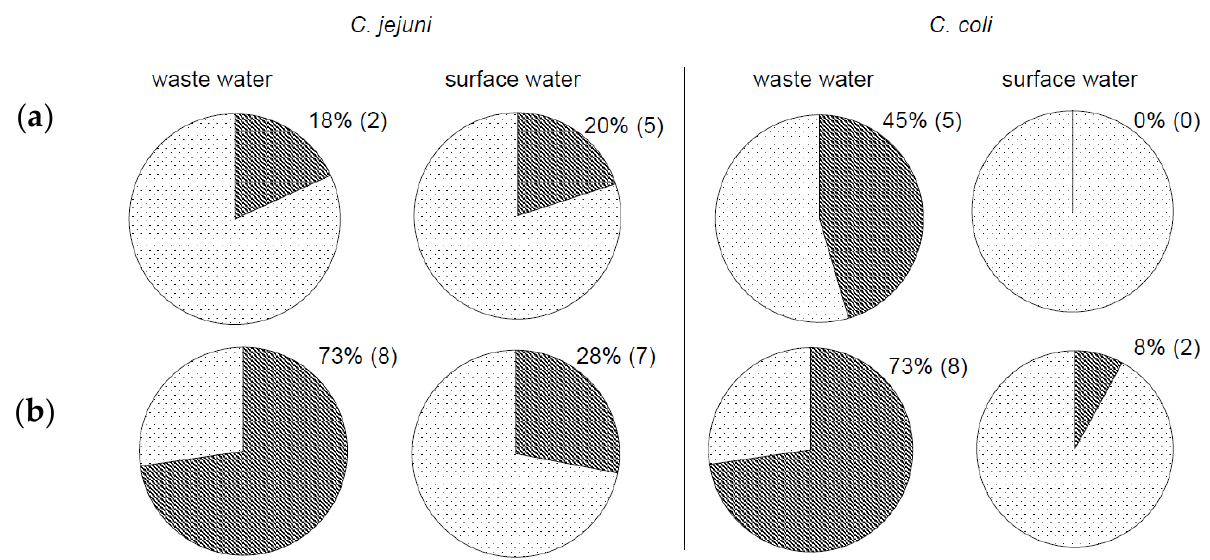
Figure 3. Comparison of isolation of thermotolerant C. jejuni and C. coli from water samples. Isolation of C. jejuni by ( a ) standard ISO 17995 method and ( b ) culture-based method without enrichment. Positive samples shown in dark colour.